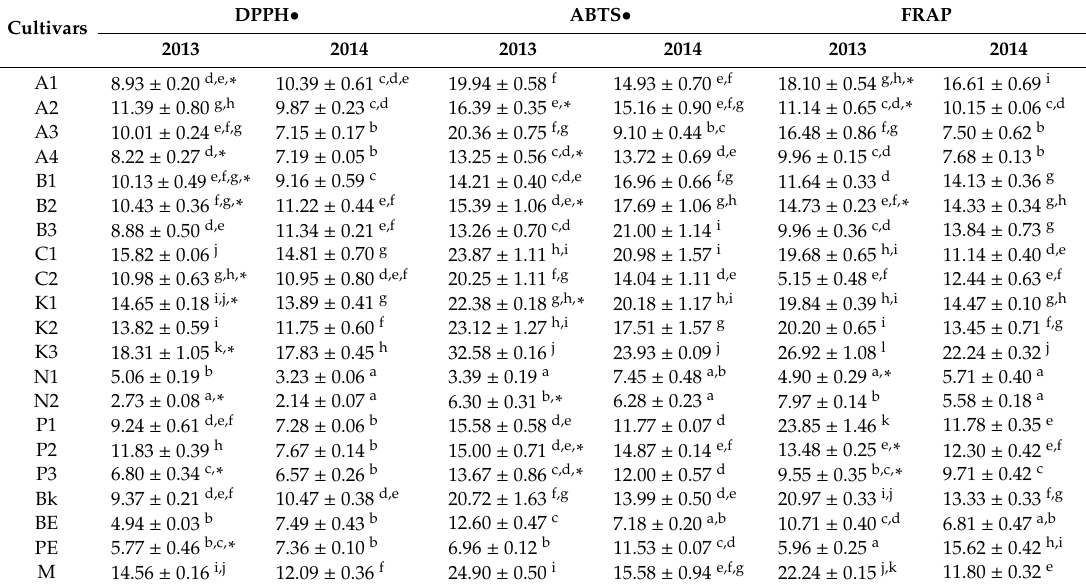
The absence of common letters ( a–l ) indicates significant di ff erences at p < 0.05; Tukey’s multiple range tests were performed for each year separately. * indicates that it does not di ff er significantly at p < 0.05, between two harvesting